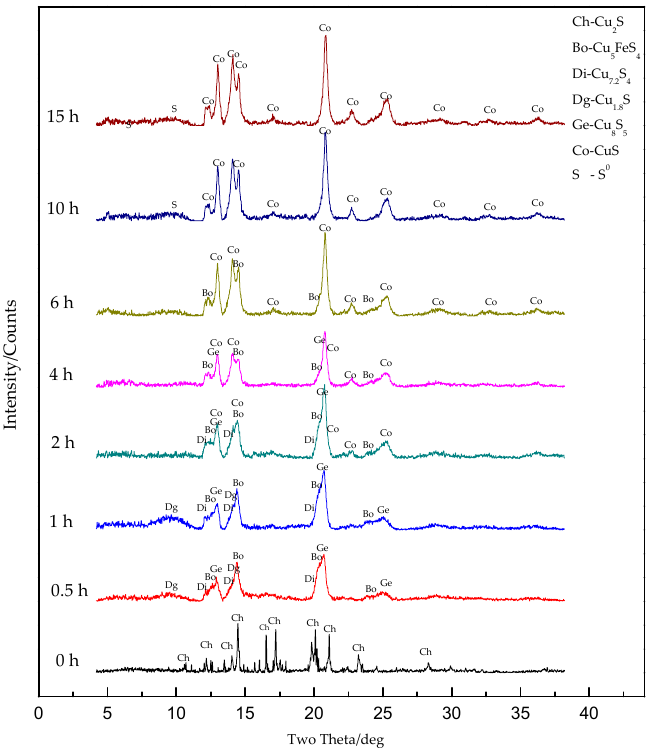
Figure 3. SRXRD results of the phase transformation process in the first stage of chalcocite acidic ferric sulfate leaching (Shanghai Synchrotron Radiation Facility